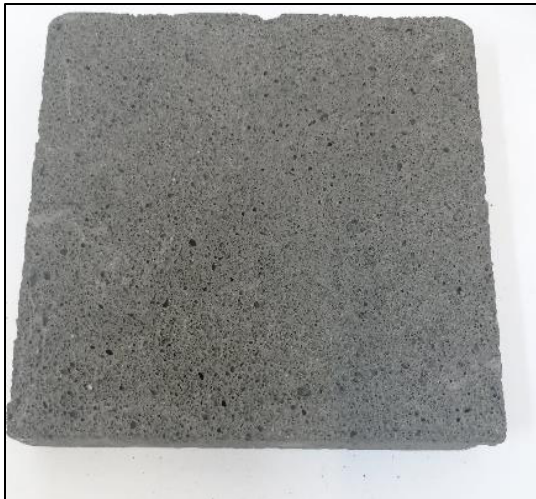
Figure 7. Sample from 100 g of cement.